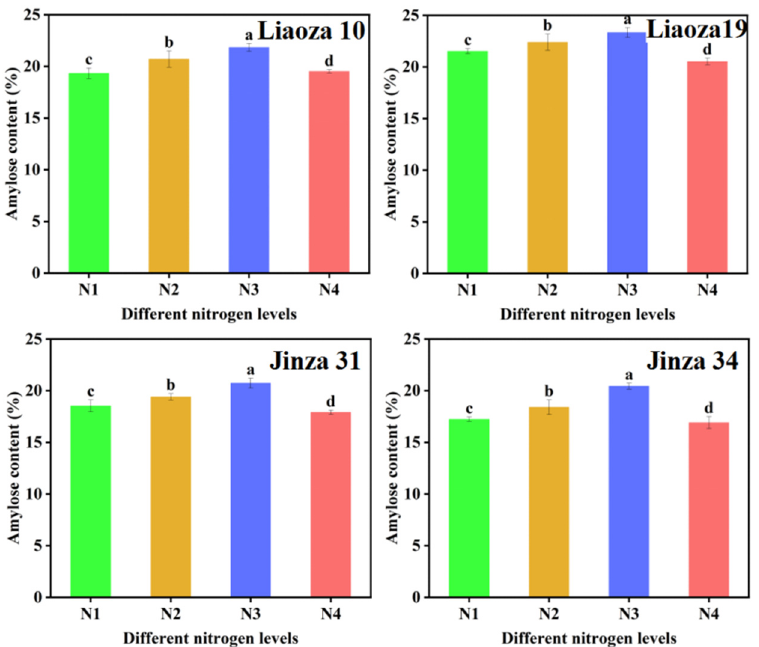
Figure 4. Effects of different nitrogen levels on the amylose content in sorghum grain. Note: values with letters in the figure mean a significant difference ( p < 0.05).